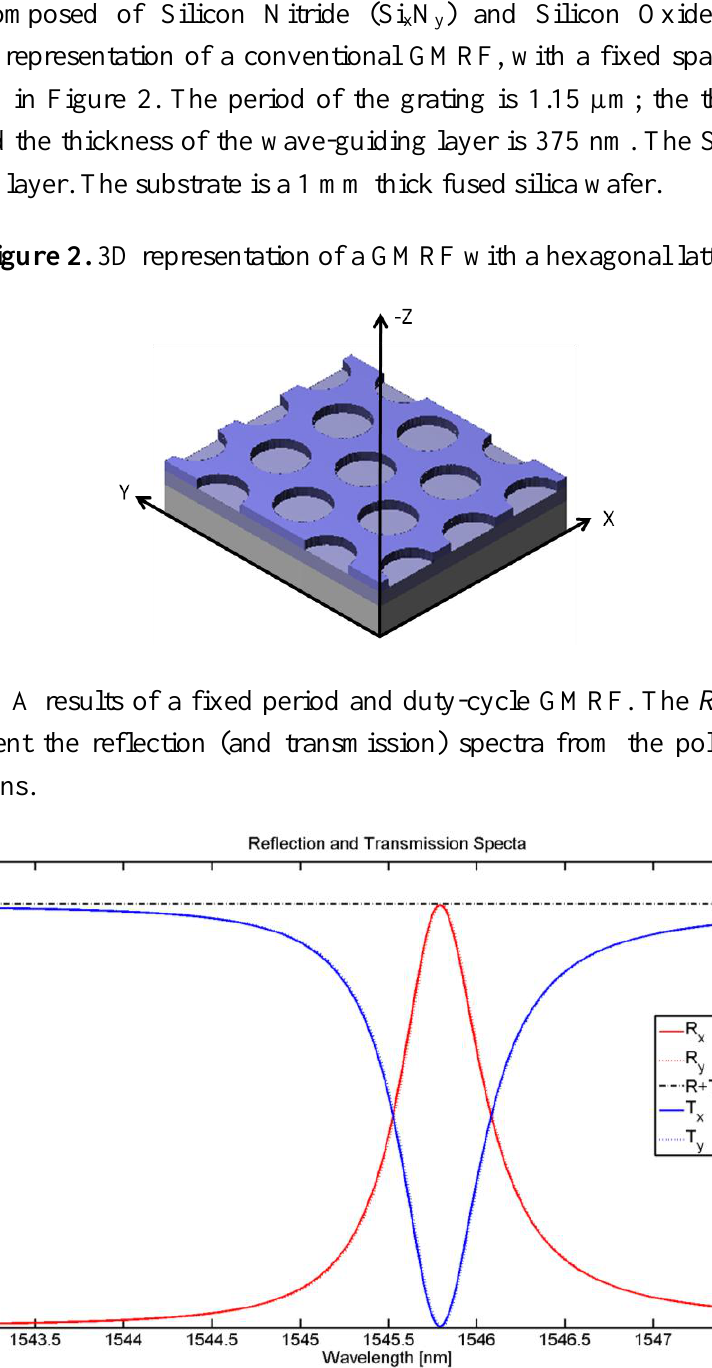
Figure 2. 3D representation of a GMRF with a hexagonal lattice.